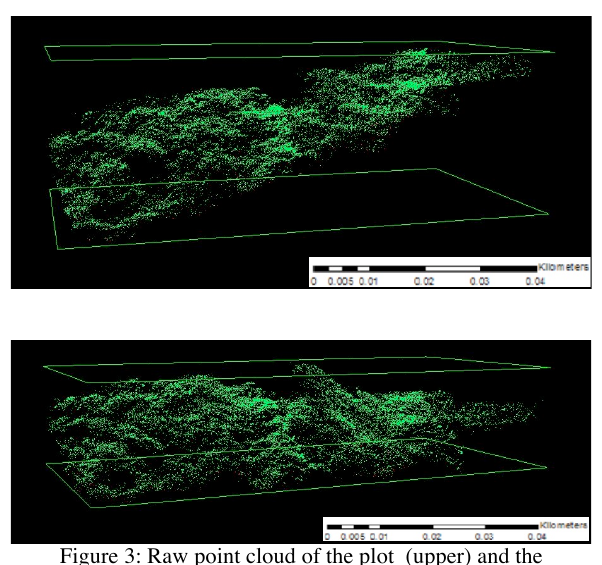
Figure 3: Raw point cloud of the plot (upper) and the normalized point-cloud (lower) The list of canopy metrics to be derived from LiDAR data are listed in Table 2.